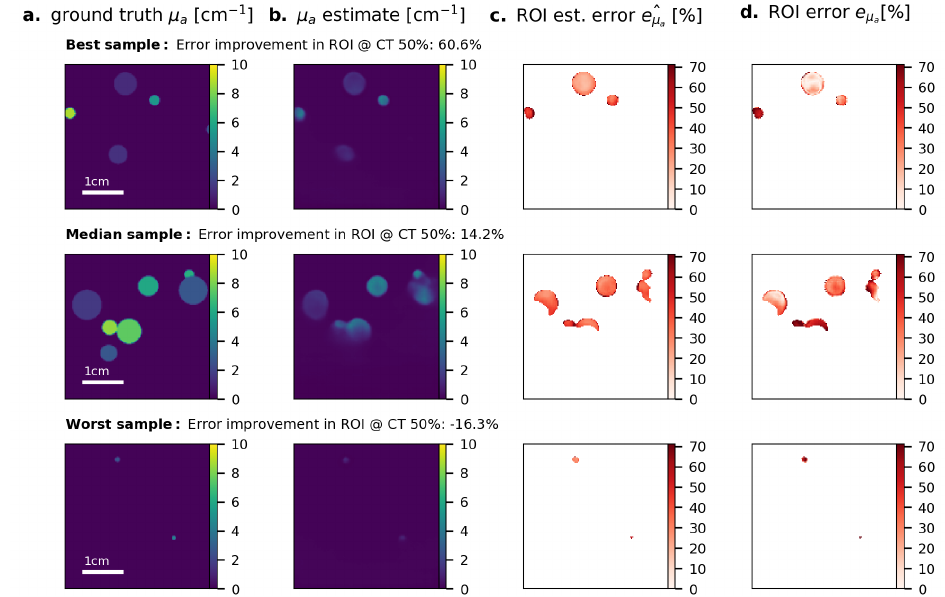
Figure A3. Sample images showing the best, the worst, and the median performance of our method when considering only the 50% most confident quantification estimations. All images show the ( a ) ground truth absorption coefficients ( b ) reconstructed absorption, ( c ) error estimate from external model, ( d ) the actual quantification